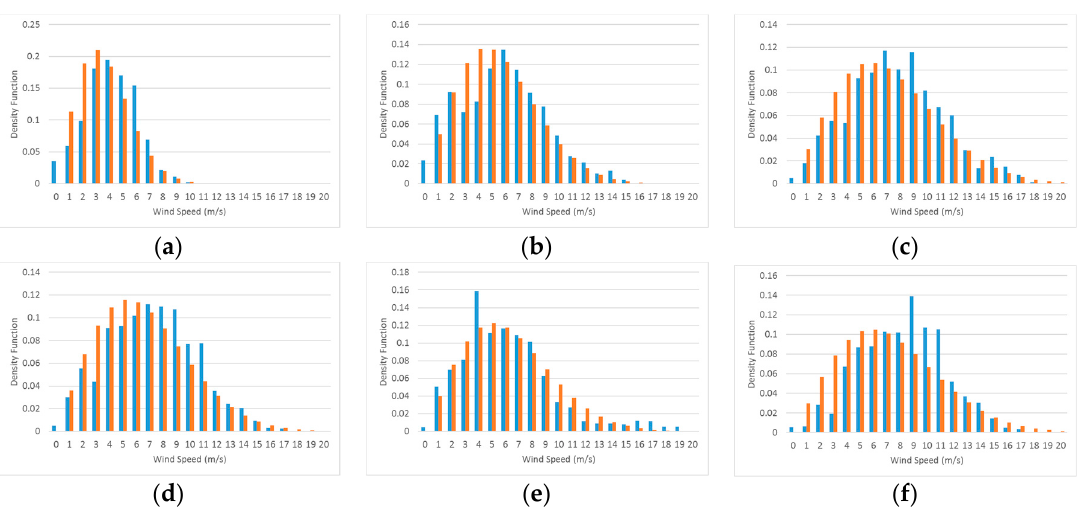
Figure 12. Six groups of samples of normalized histograms of wind speeds, in blue, and fitted Weibull distribution, in orange, for group periods of 10 days each during WS season. Each graph corresponds to the following period ( a ) 01/01/2010–01/10/2010; ( b ) 01/11/2010–01/20/2010; ( c ) 01/21/2010–01/30/2010; ( d ) 01/31/2010–02/09/2010; ( e ) 02/10/2010–02/19/2010; ( f ) 02/20/2010–03/01/2010.